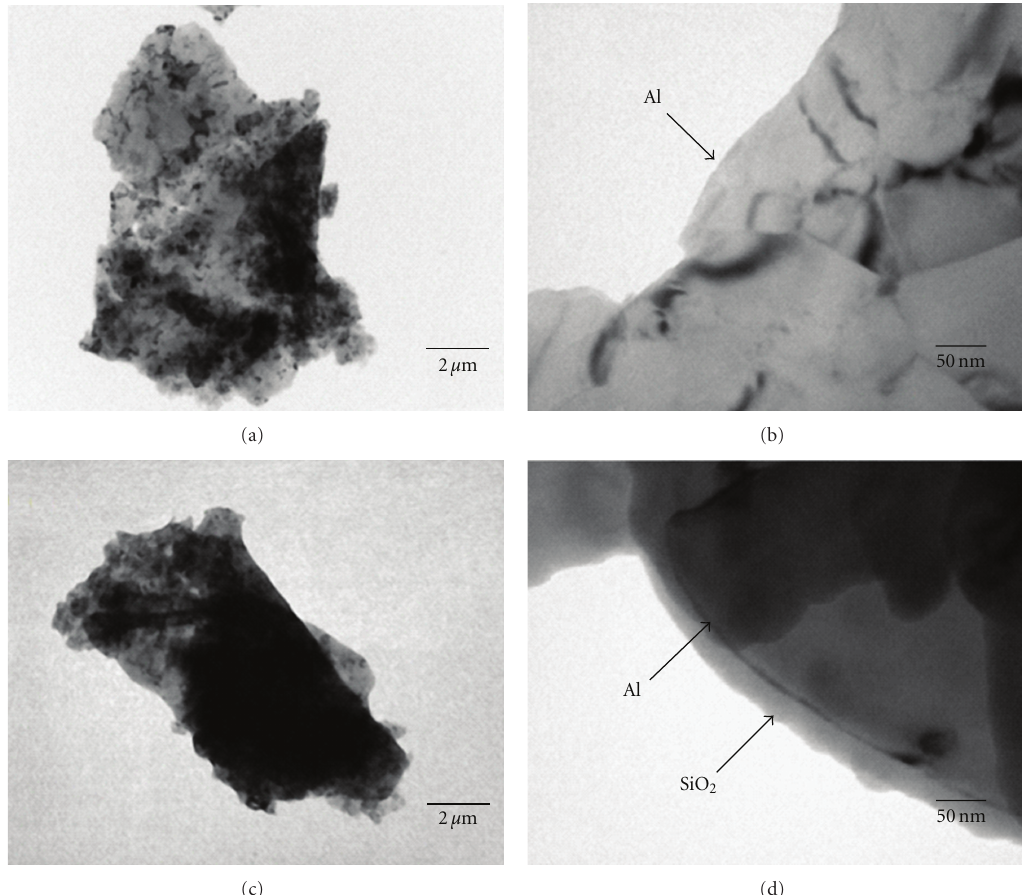
Figure 3: TEM images of (a) Al microflake without SiO 2 shell layer, (b) magnified view of (a), (c) Al microflake with SiO 2 shell layer, and (d) magnified view of